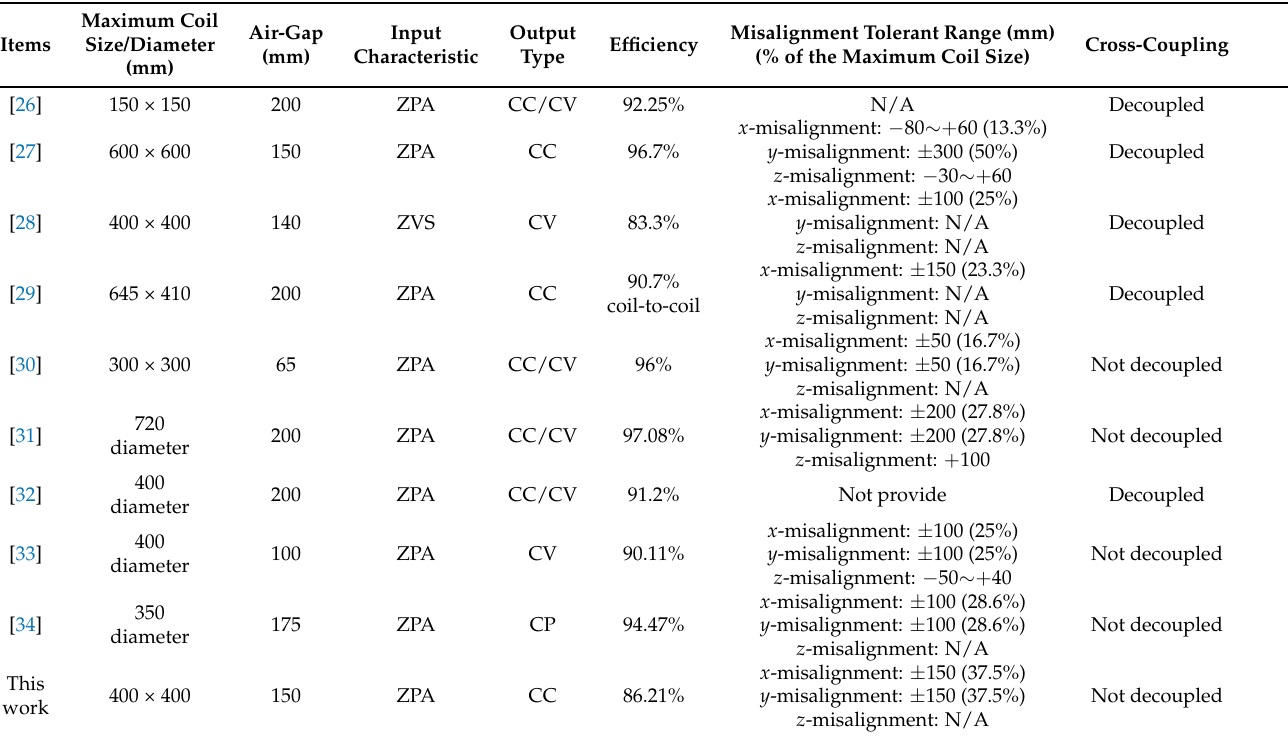
Table 5. Comparison with other